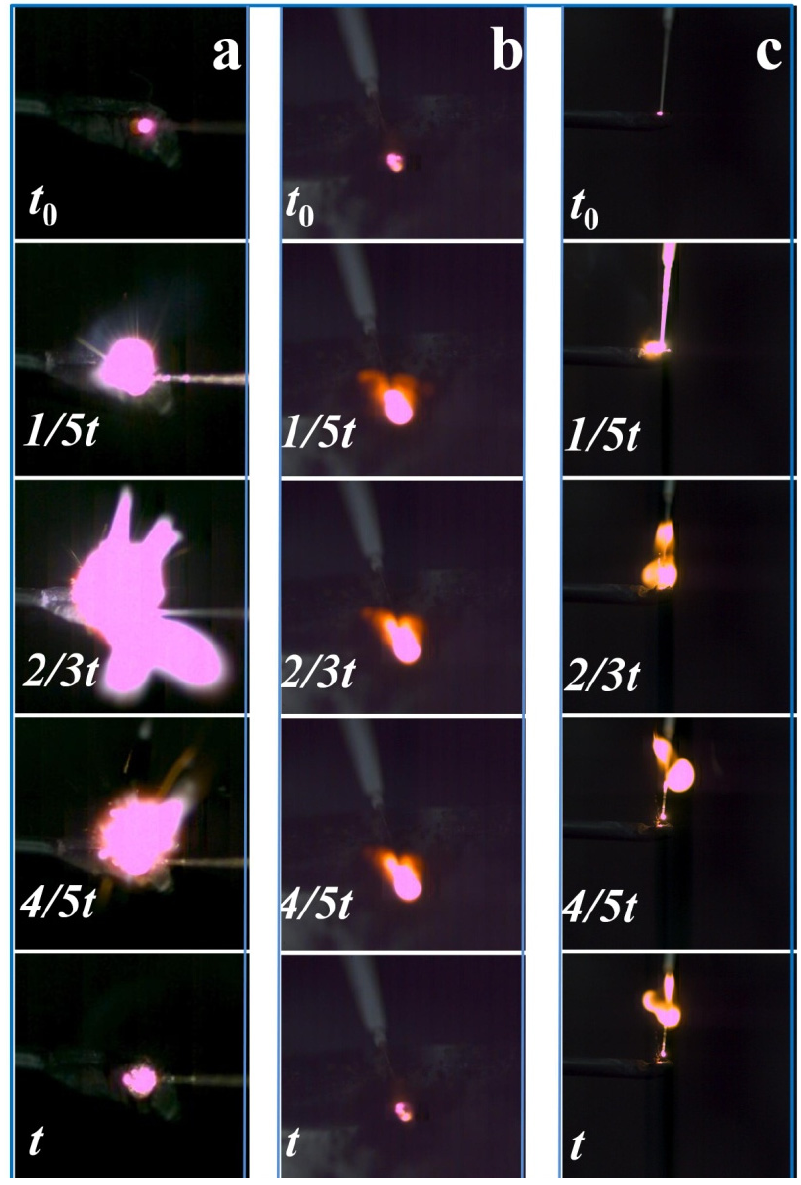
Figure 8. Burning flame morphology of Mg ( a ), B ( b ), and MgB 2 ( c ) samples.